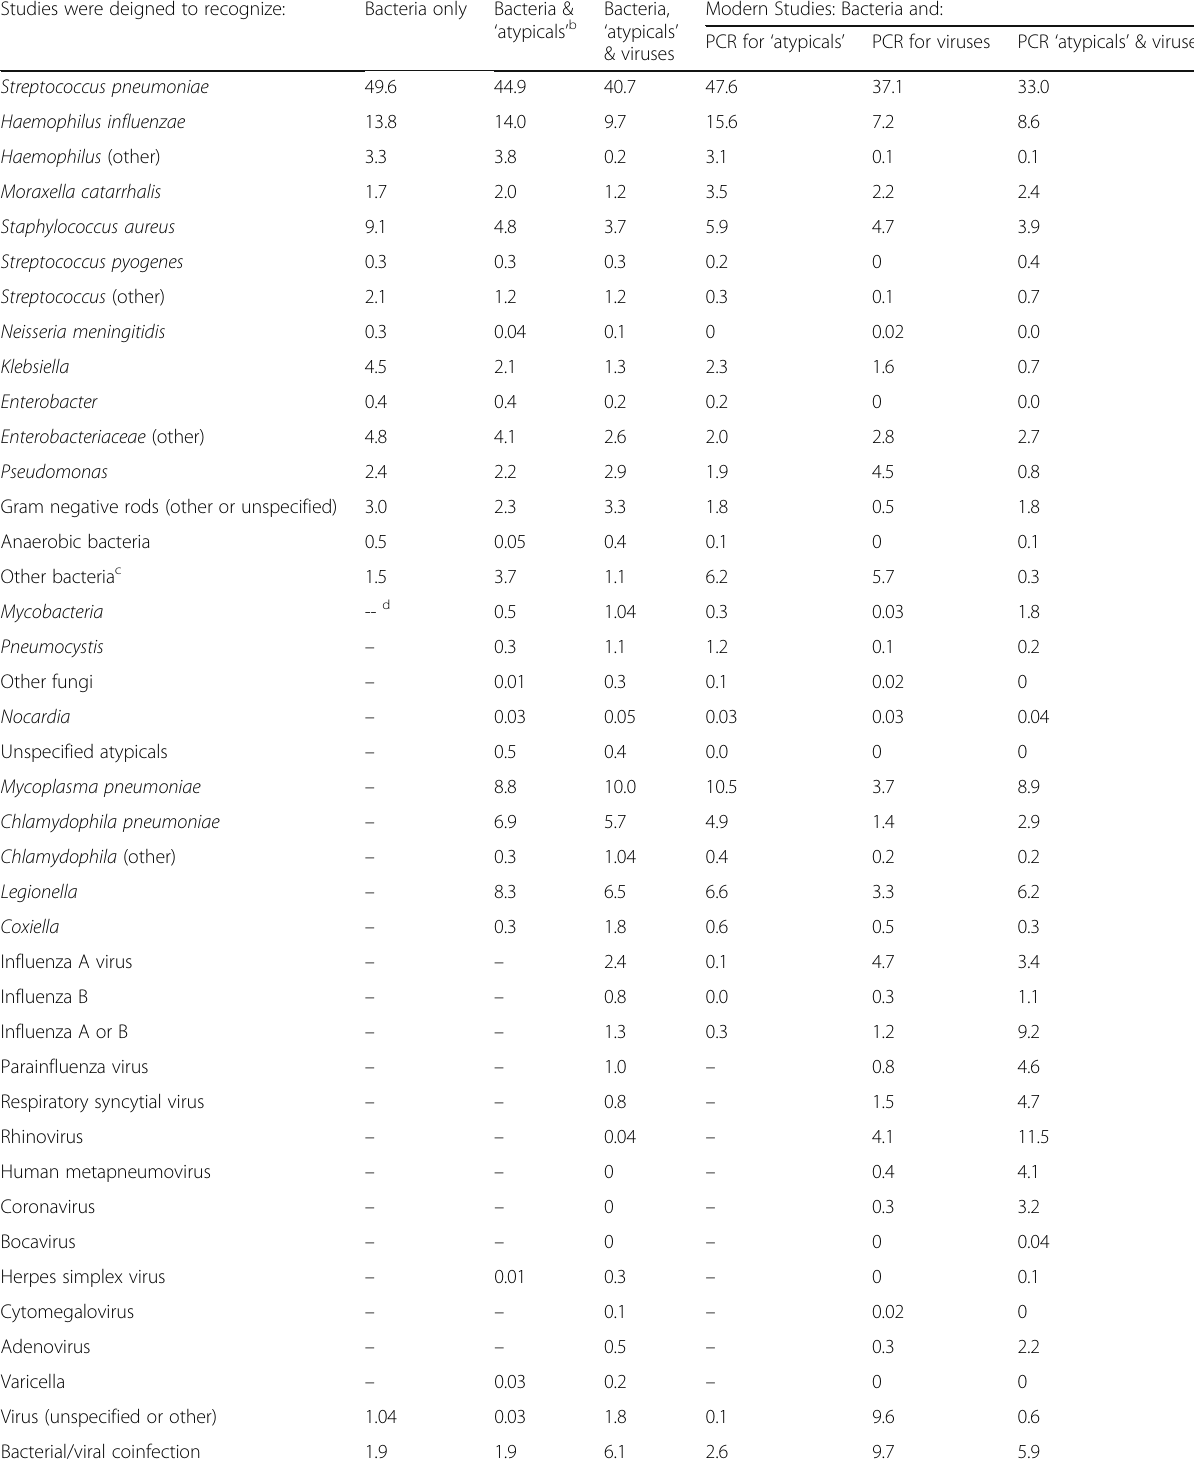
Table 2 Frequency of causative pathogens in CAP, stratified based on microbiologic techniques a Studies were deigned to recognize: Bacteria only Bacteria &